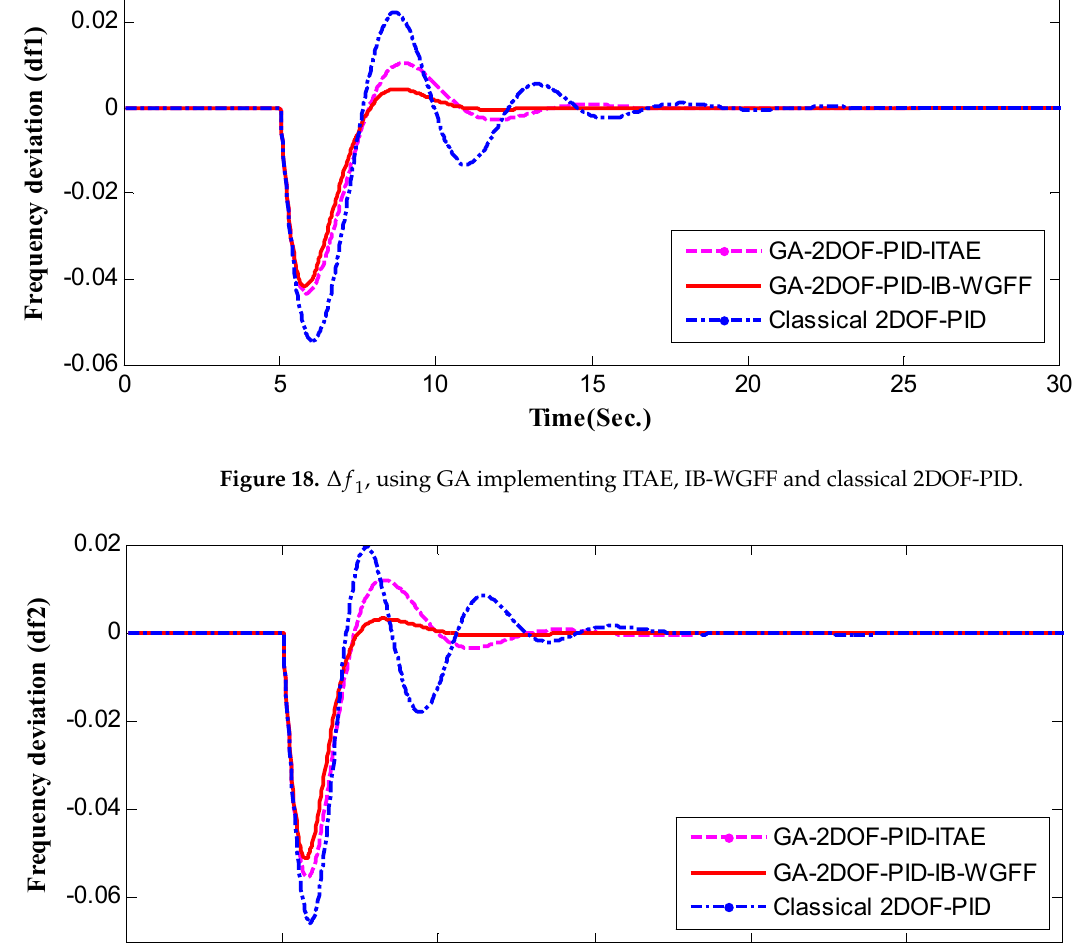
Figure 20. Δ P using GA using GA implementing ITAE, IB-WGFF and classical 2DOF-PID.